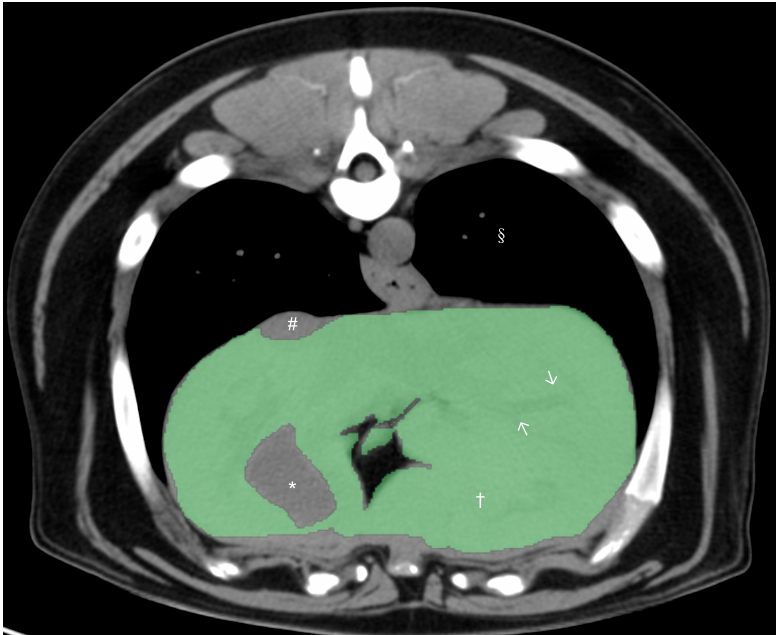
Figure 1. Precontrast transverse abdominal CT images used for measuring liver volume in dogs. The segmentation of the liver was manually selected as Region of Interests (ROIs: green regions). Note that the hepatic vessels within liver parenchyma were included (white arrows). The gall bladder, hepatic lobe fissure, and hepatic vessels present outside hepatic parenchyma were excluded. Window width, 350 HU, and window level, 40 HU. Liver parenchyma (†), gallbladder (*), caudal vena cava (#), and pulmonary parenchyma (§).